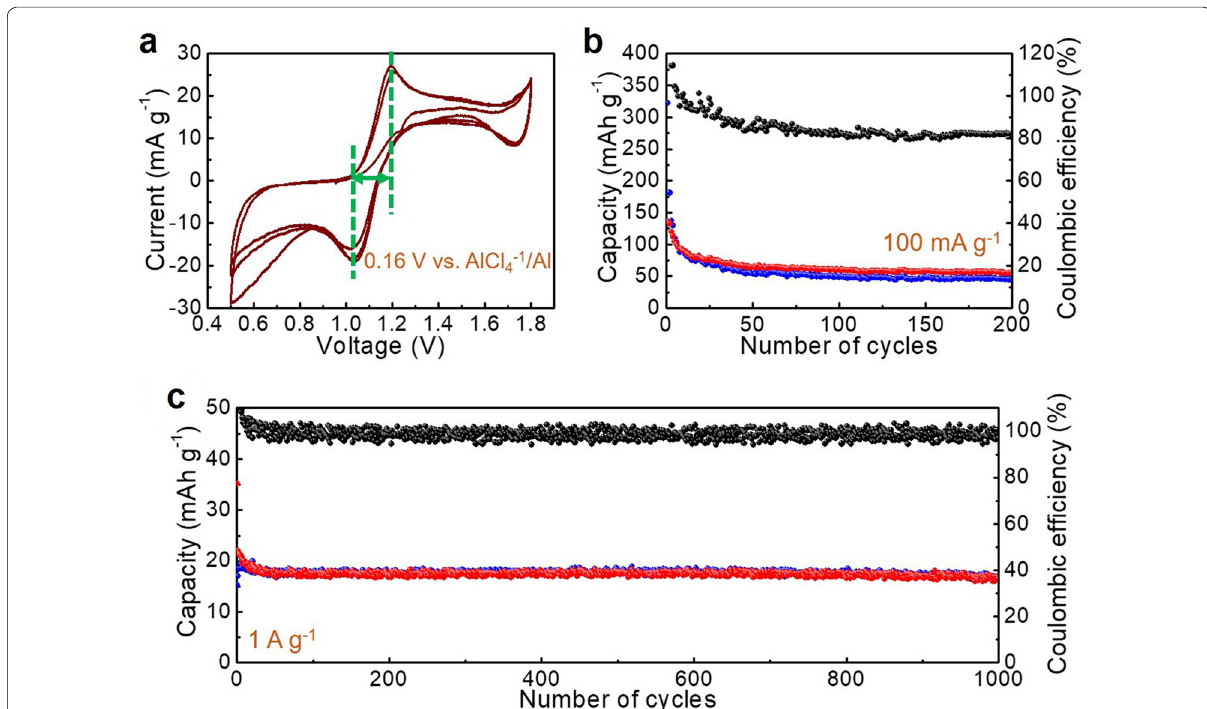
Fig. 5 a CV curves and repeated charge/discharge measurements at b 100 mA g − 1 and c 1,000 mA g − 1 for the as‑prepared SC/Sm as a cathode material of AIBs